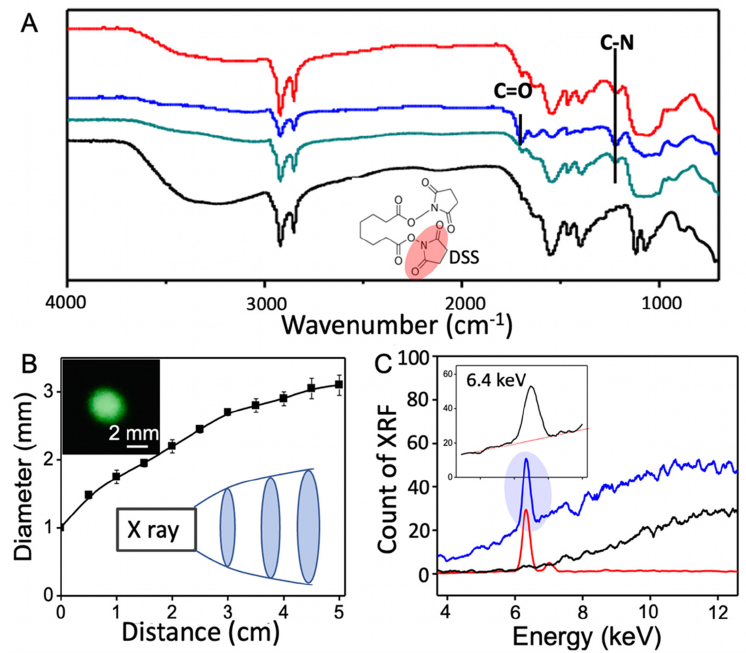
Figure 4. FTIR spectra of nanoparticles after surface modification: ( A ) As obtained nanoparticles (black), APTES modified (green), DSS (blue) and biotin conjugated (red), respectively. The diameter of the primary X-ray spot at various distances ( B ) and an optical image of a fluorescent spot (inset); X-ray fluorescence spectra ( C ) of nanoparticles (red), dehydrated hydrogel (black) and dehydrated hydrogel with nanoparticles (blue), where the inset plot shows the iron peak from nanoparticles in dehydrated hydrogels.